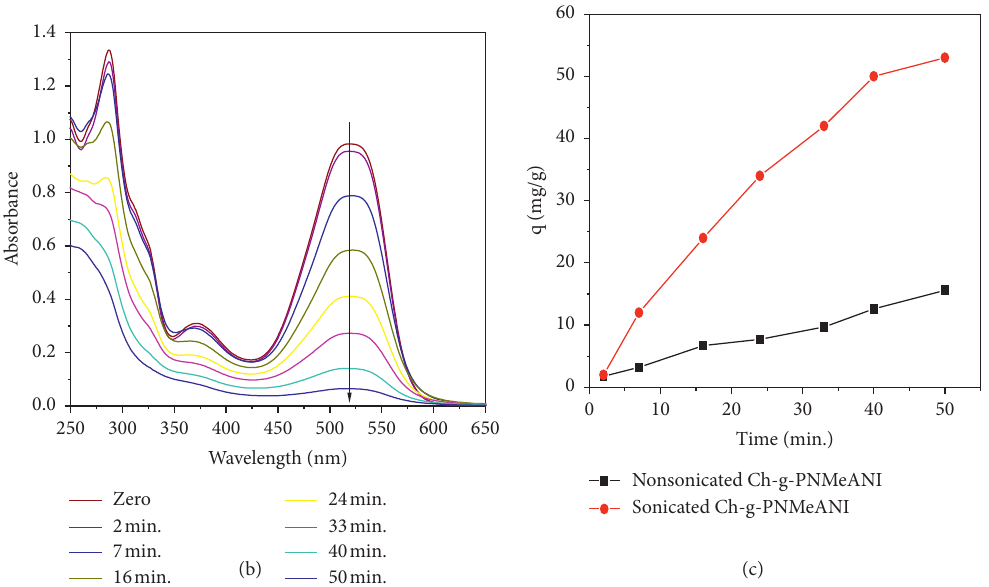
Figure 6: (a) Image shows the complete uptake of RR by Ch-g-PNMeANI adsorbent. (b) Adsorption-induced changes of the absorption spectrum of RR after different contact times with Ch-g-PNMeANI. (c) The variation of adsorption capacity with adsorption time for aqueous solution of RR dye onto nonsonicated (black line) and sonicated (red line)